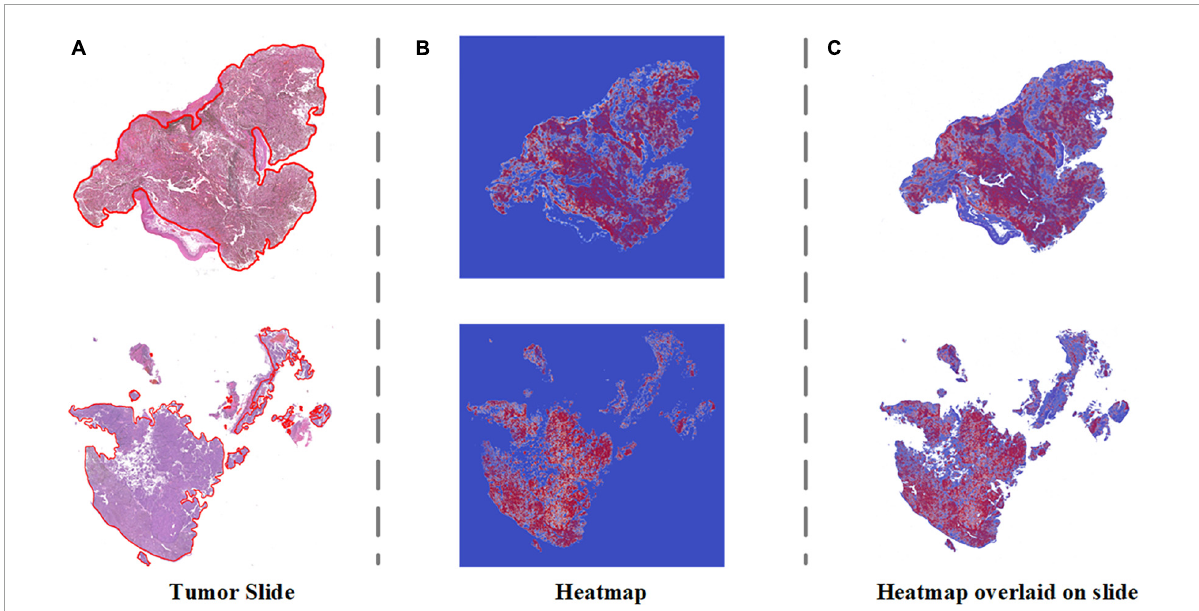
FIGURE5 Visualization heatmap of pathological slides based on SSL. (A) The original pathological slide with tumor area delineated (H&E staining, × 40 scanned). (B) Probabilistic heatmap of the tumor slides generated by the algorithm. Red indicates higher malignancy. (C) Overlap of the tumor slide image and probabilistic